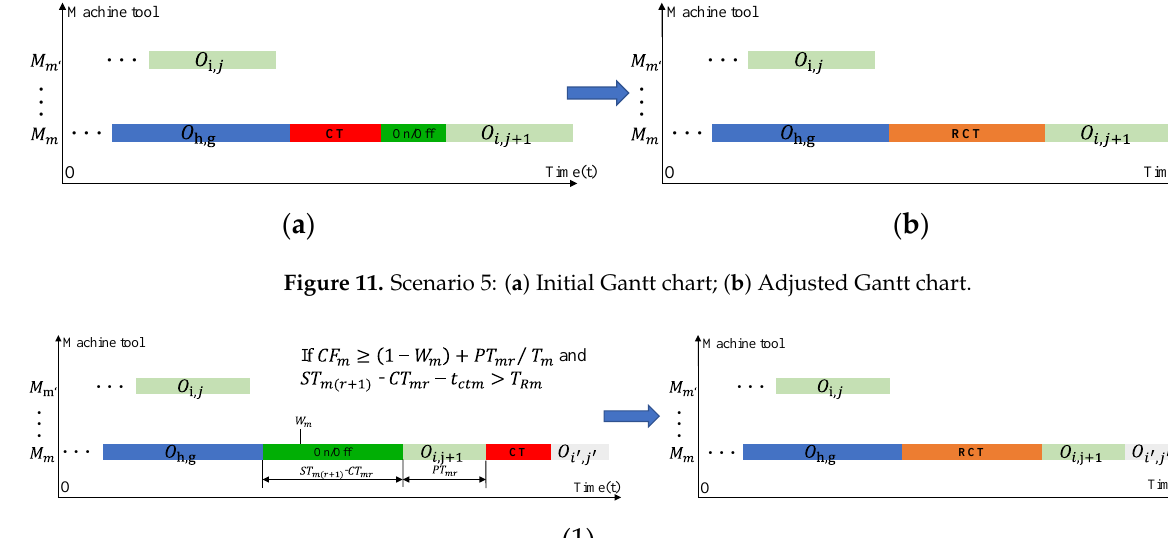
Figure 10. Scenario 4: ( a ) Initial Gantt chart; ( b ) Adjusted Gantt chart.